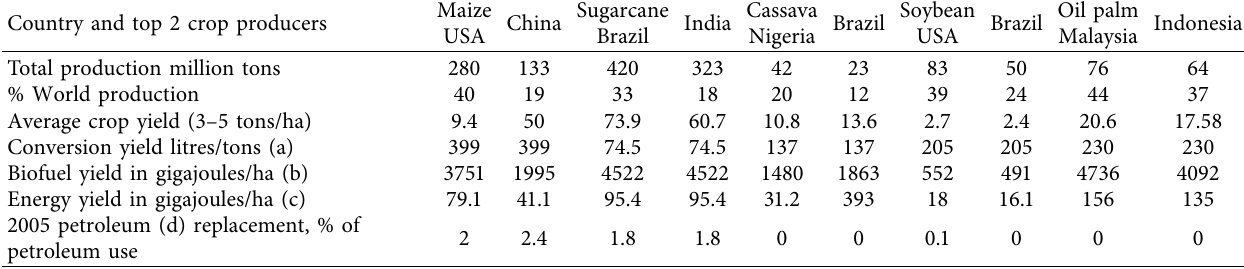
Table 1: Production of five major feedstocks and biofuel energy yields in 2005 [6, 10].